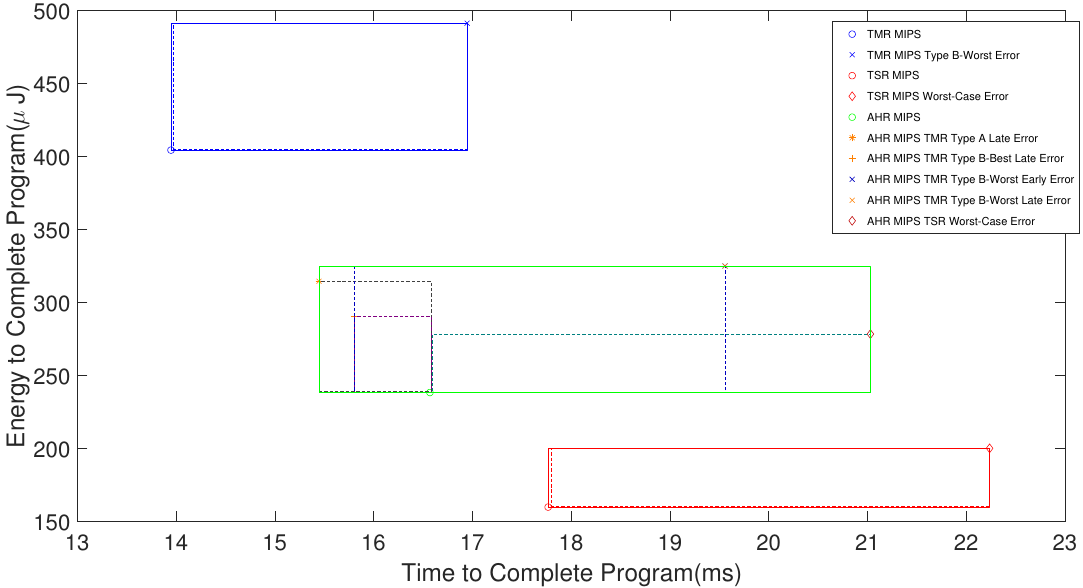
Figure 7. Average performance bounds for AHR MIPS with a TMR to TSR point at 15,000 instructions. The corners of the bounding box encompassing the TMR MIPS Type B-Best and Type B-Worst errors is shown as a dotted blue line. This box indicates that average program completion time and energy usage for a TMR MIPS program encountering a Type B error will end up within this box and it nearly overlaps the second box indicated by a solid blue line. The second box is used to outline the average performance of TMR MIPS when errors may or may not be present. It includes the no error, TMR Type A, and TMR Type B